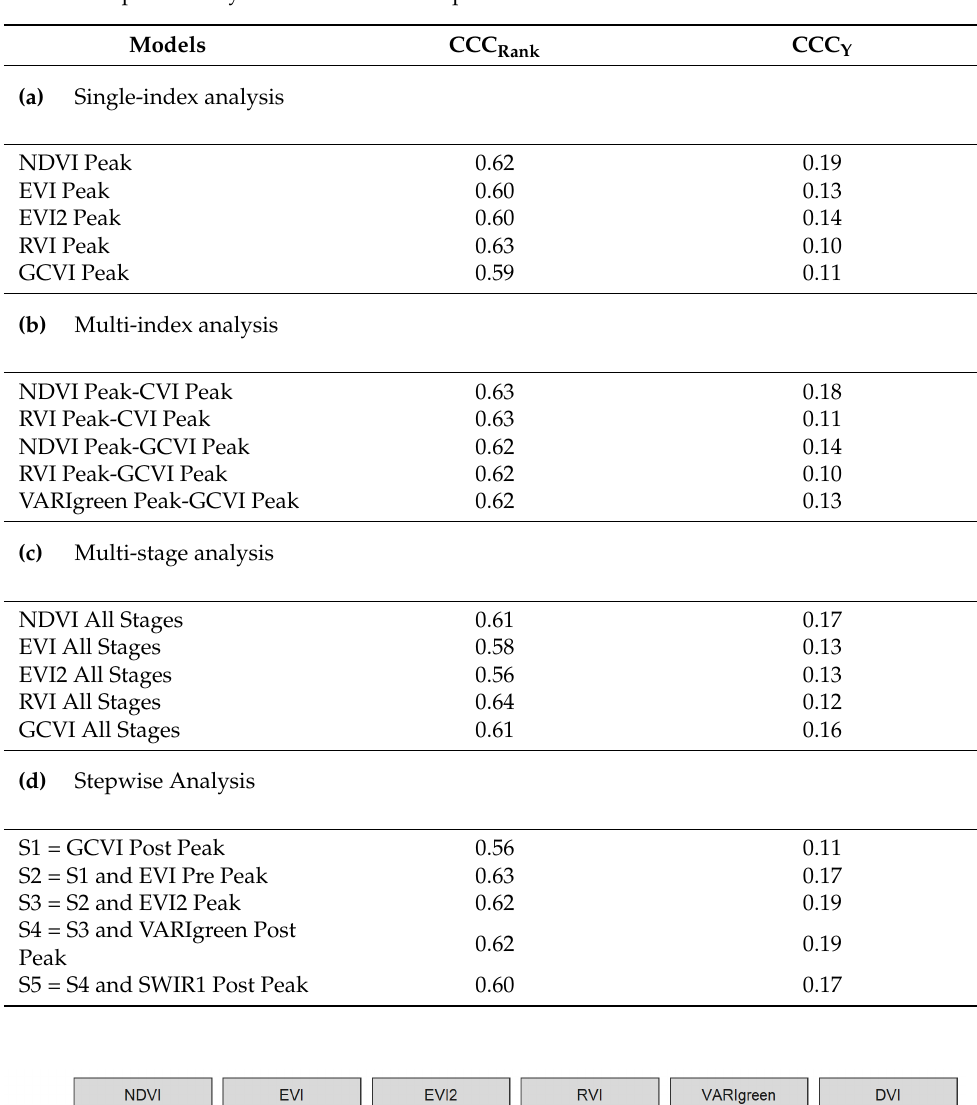
Table 3. Median CCC values from cross-validation based on manually selected covariates and those from the stepwise analysis. Covariates for stepwise models are referred to as S1–S5.